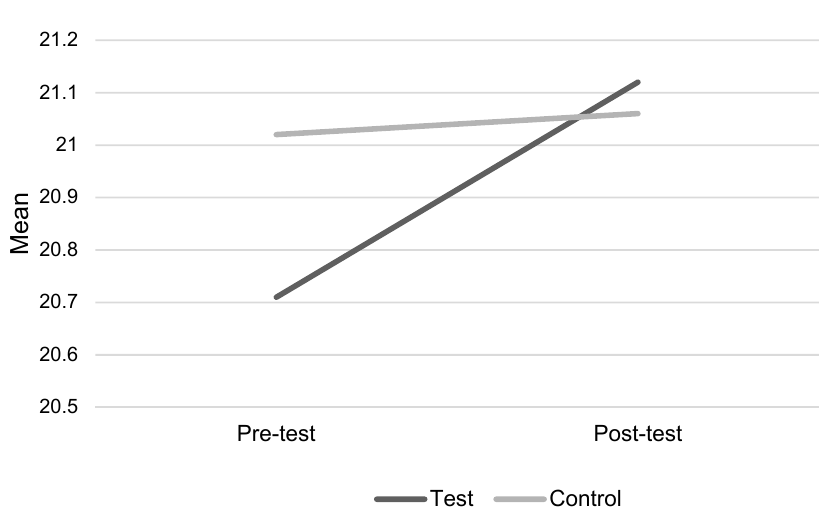
Figure 2. Children’s scores for compassion towards animals.